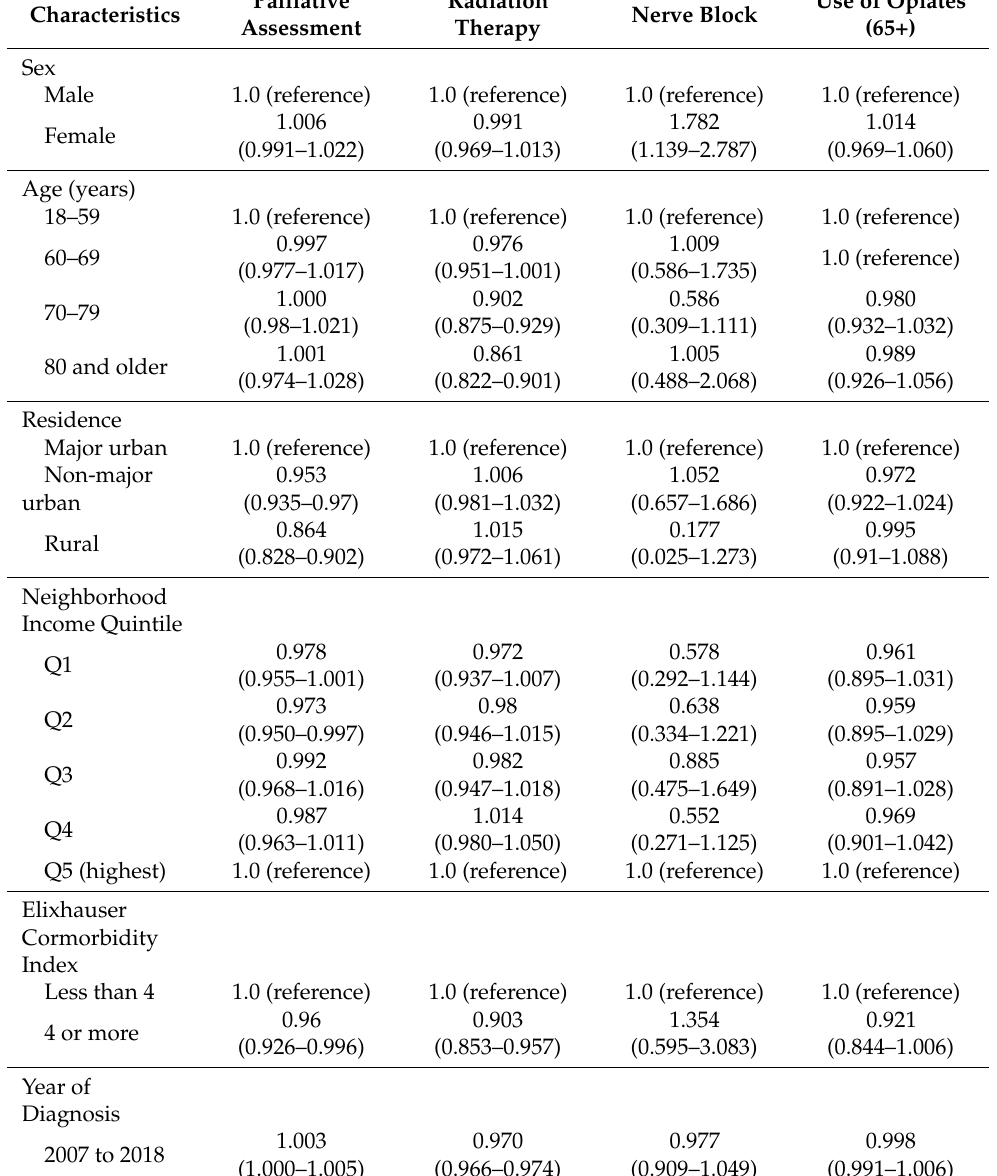
Table 3. Multivariable modified Poisson model for patients who reported moderate-to-severe pain ESAS